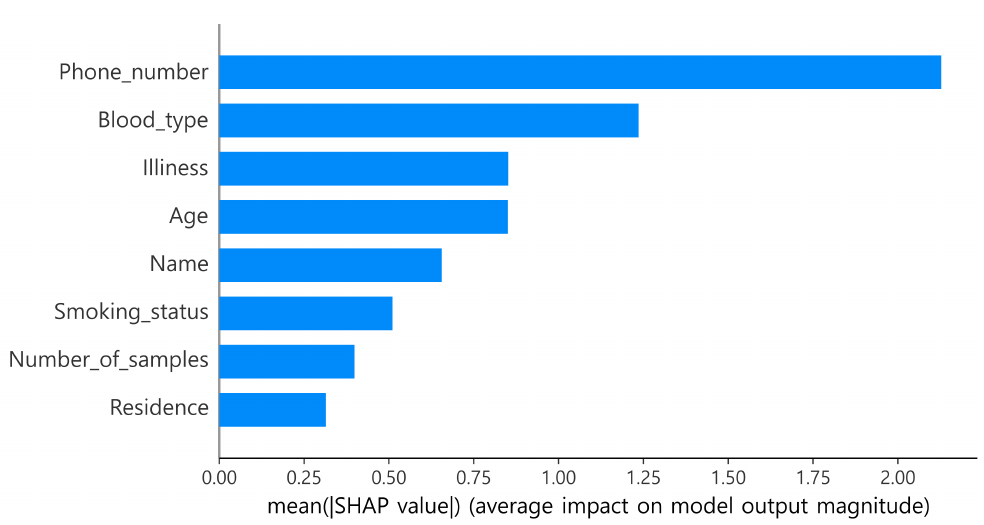
Figure 7. Feature importance based on Shapley additive explanation (SHAP) values.